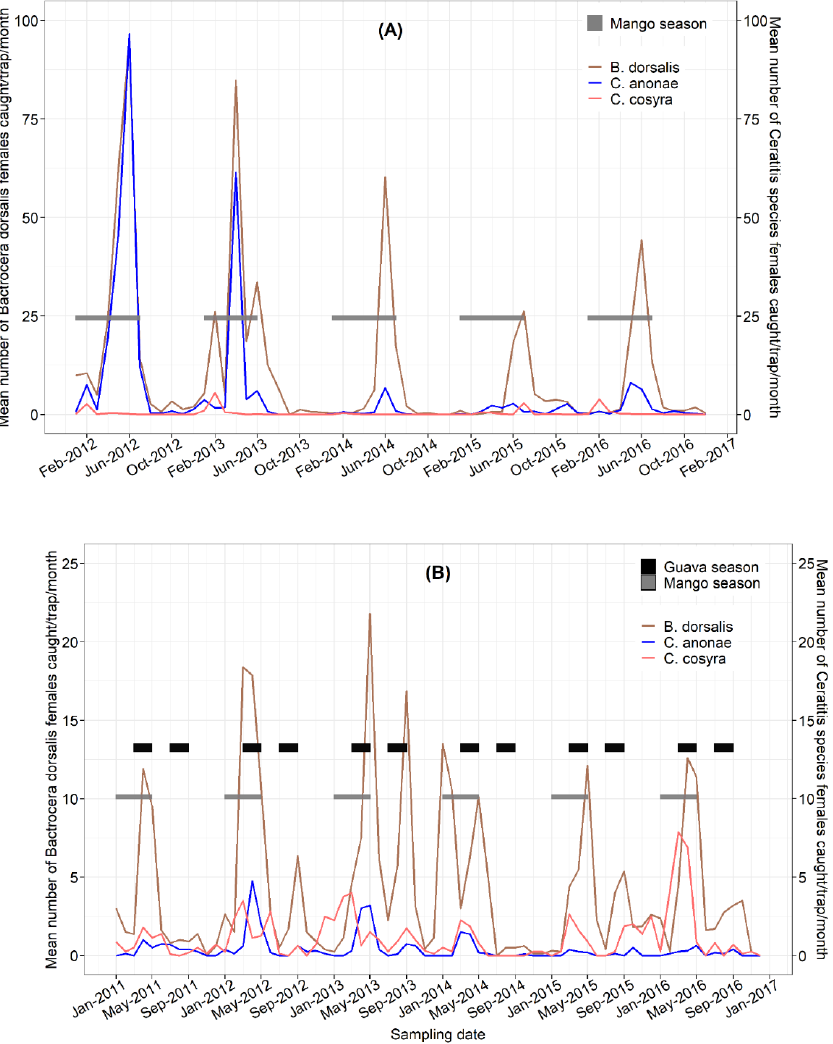
Figure 4. Yearly dynamics of tephritid fruit fly females in traps baited with Torula yeast in Foumbot WH-MR ( A ) from January 2012 to January 2017, and Nkolbisson HF-BR ( B ) from January 2011 to December 2016, in relation to the ripening periods of mango and guava. At Nkolbisson HF-BR, the period of high trap counts of B. dorsalis occurred from March to May and mostly peaked in April, coinciding with the full mango and guava seasons, while C. cosyra were more active from January to April with peaks observed in March (Figure 4B). Ceratitis anonae followed similar abundance patterns to B. dorsalis , as in Foumbot WH-MR, but occurred in much lower numbers compared with its abundance in the WH-MR AEZ.